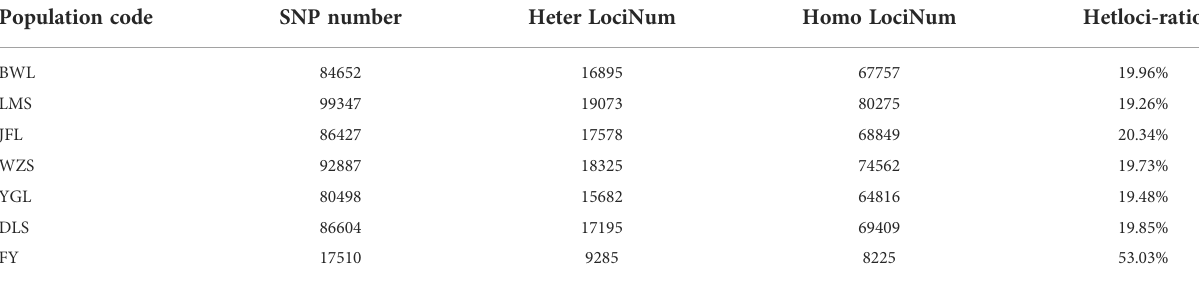
TABLE 3 SNP Statistical